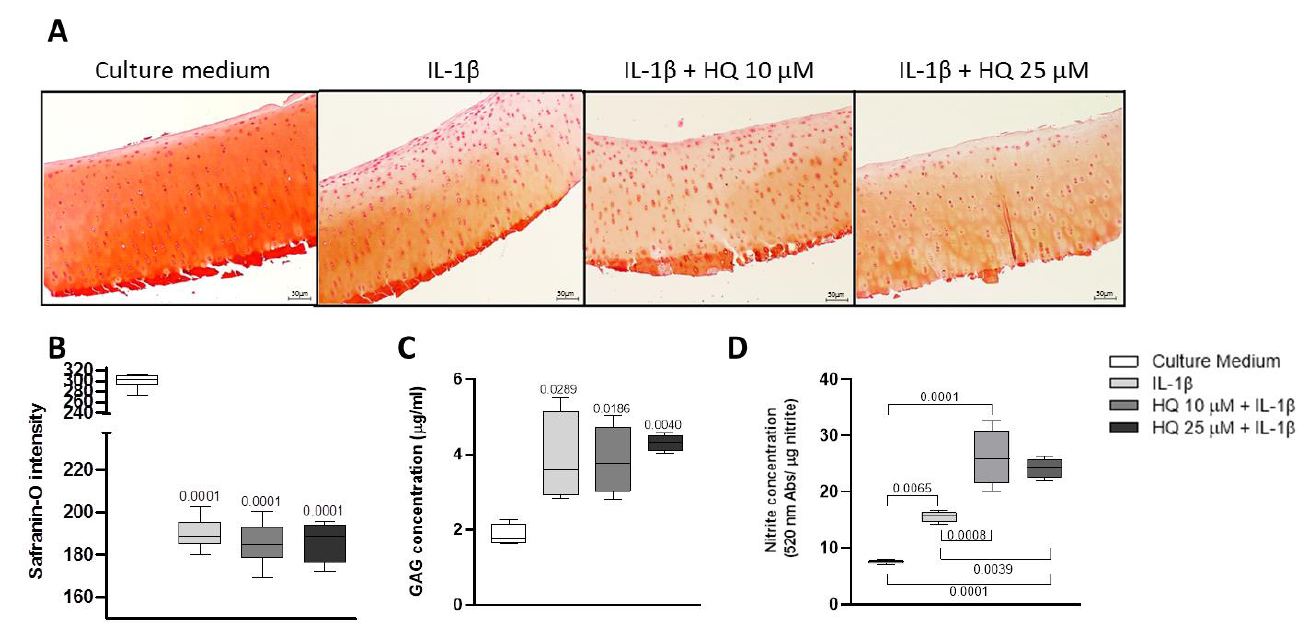
Figure 5. HQ treatment increases the pro-inflammatory activity of IL-1 β in articular cartilage explants. Bovine articular cartilage explants were pre-incubated with CM or with IL-1 β (20 ng/mL) for 4 h and subsequently incubated with HQ (10, 25 or 50 µ M) for 72 h. The co-stimulation did not alter GAGs synthesis and release ( A – C ) but increased nitrite production ( D ) in comparison to stimulation with IL-1 β alone. 10 × magnification. Data represent ± SEM from four independent experiments and were analysed with one-way ANOVA.